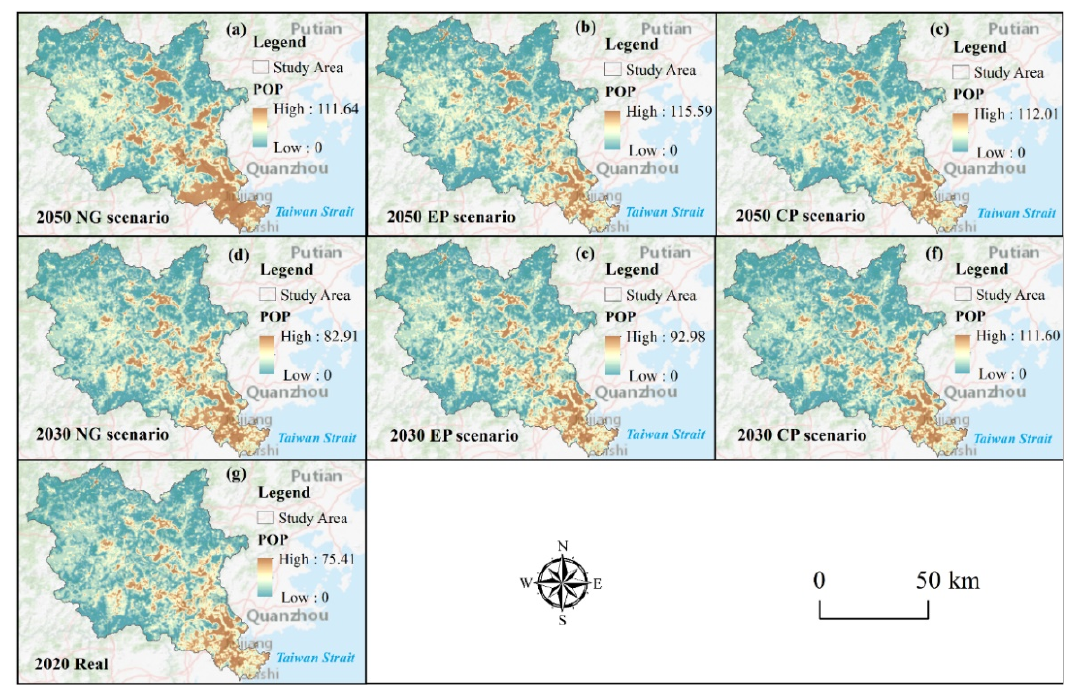
Figure 7. Spatial distribution of future population (POP, million people/100 m 2 ) in Jinjiang Basin. NG, EP, and CP scenarios represent natural growth, ecological protection, and cropland protection scenarios, respectively. Subfigures ( a ), ( b ) and ( c ) are the POPs under NG, EP and CP scenarios in 2050, respectively. Subfigures ( d ), ( e ) and ( f ) are the POPs under NG, EP and CP scenarios in 2030, respectively. Subfigures g is the POP in 2020.